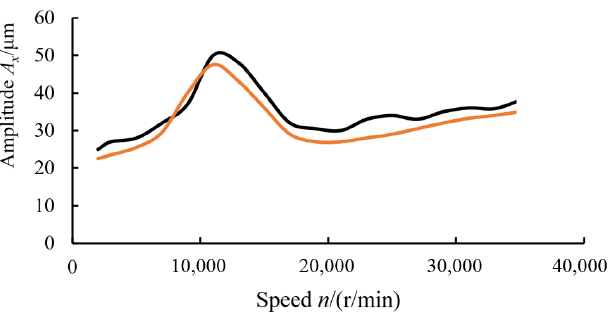
Figure 23. Unbalance response comparison obtained from simulation and test data.